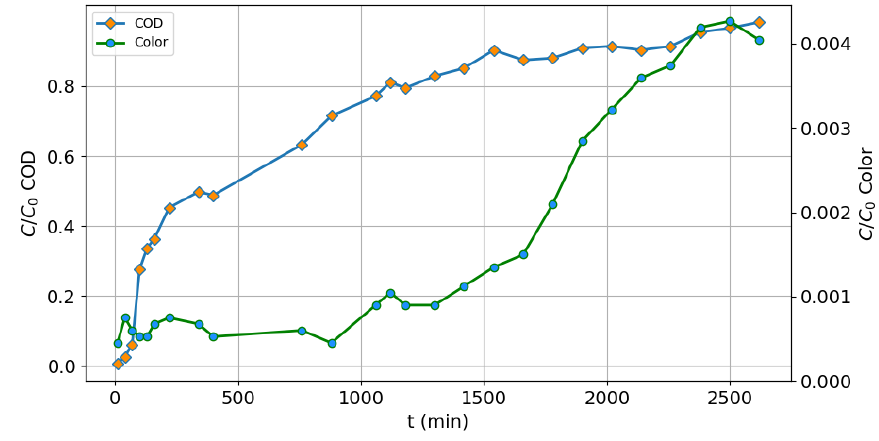
Figure 7. Saturation curve for the COD and color (GAC FE).